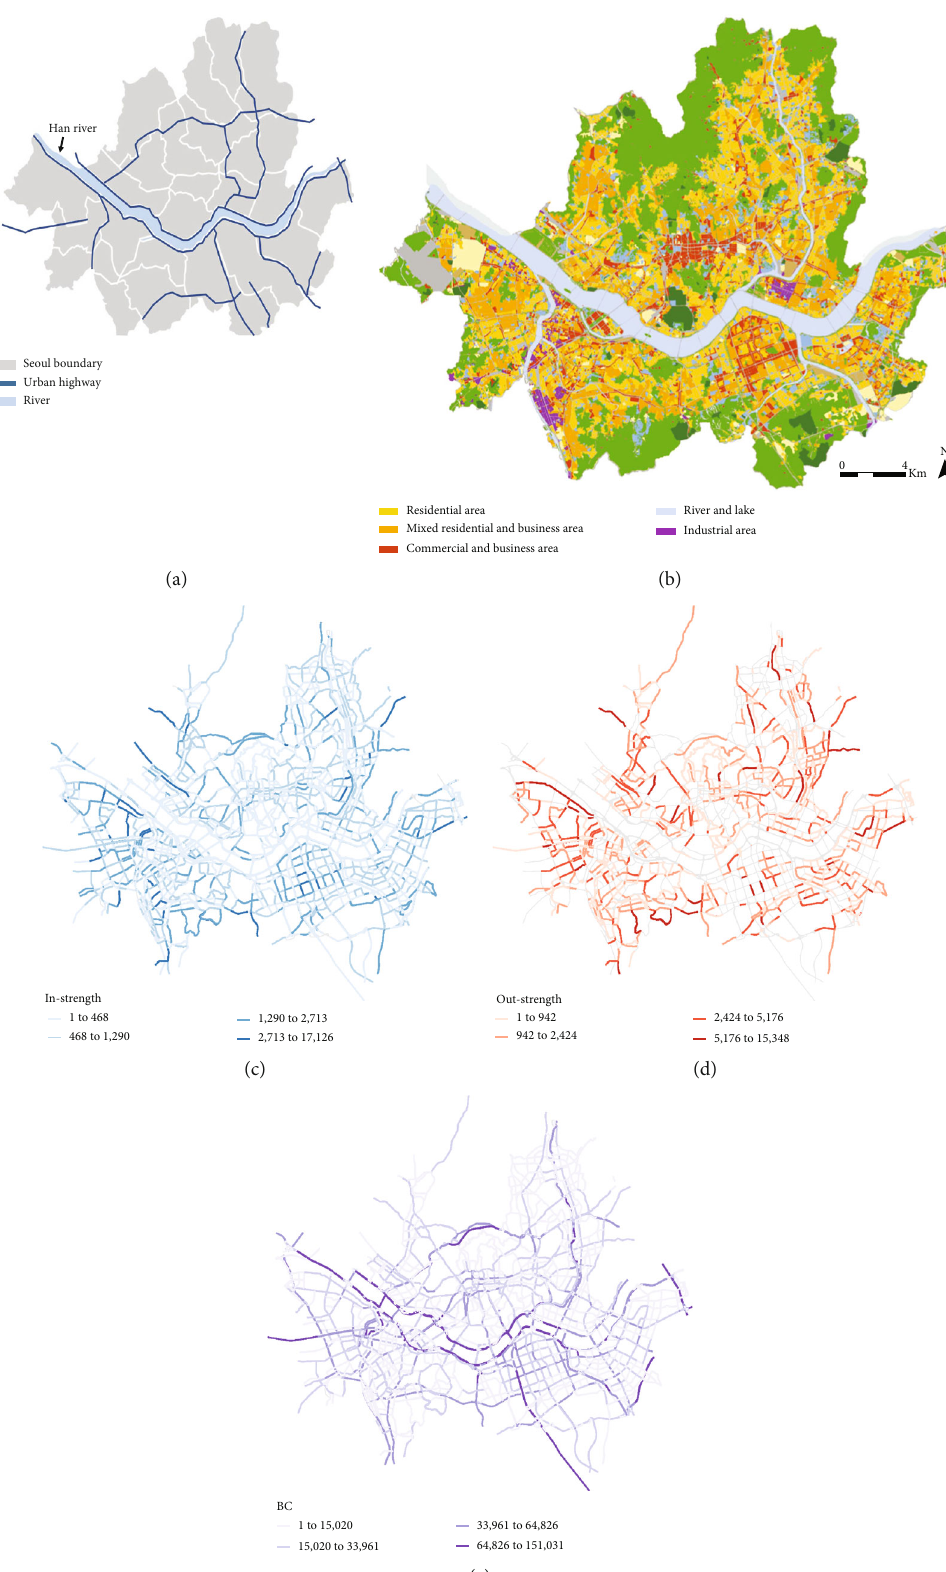
Figure 4: Link attributes in Seoul road network; (a) urban highways in Seoul, (b) land use map of Seoul (The Seoul Research Data Service, https://data.si.re.kr/node/45), (c) in-strength, (d) out-strength, (e) betweenness centrality of road links in